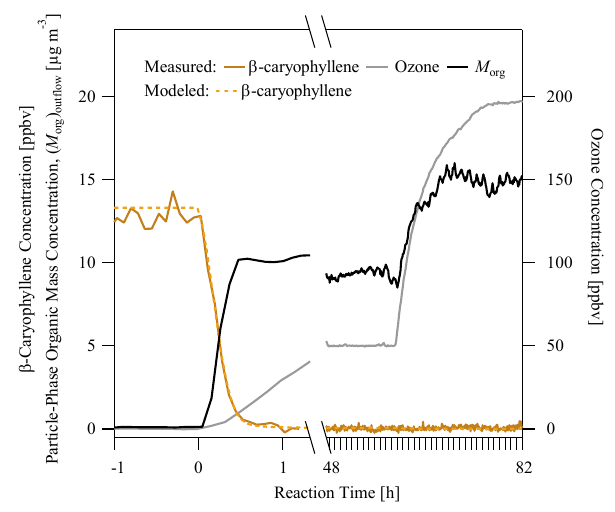
Fig. 2. A typical time series for the transient phase of the CMFR showing the loss of β -caryophyllene, the appearance of particle- phase secondary organic material following the introduction of ozone, and the increase of particle-phase organic material follow- ing the elevation of ozone